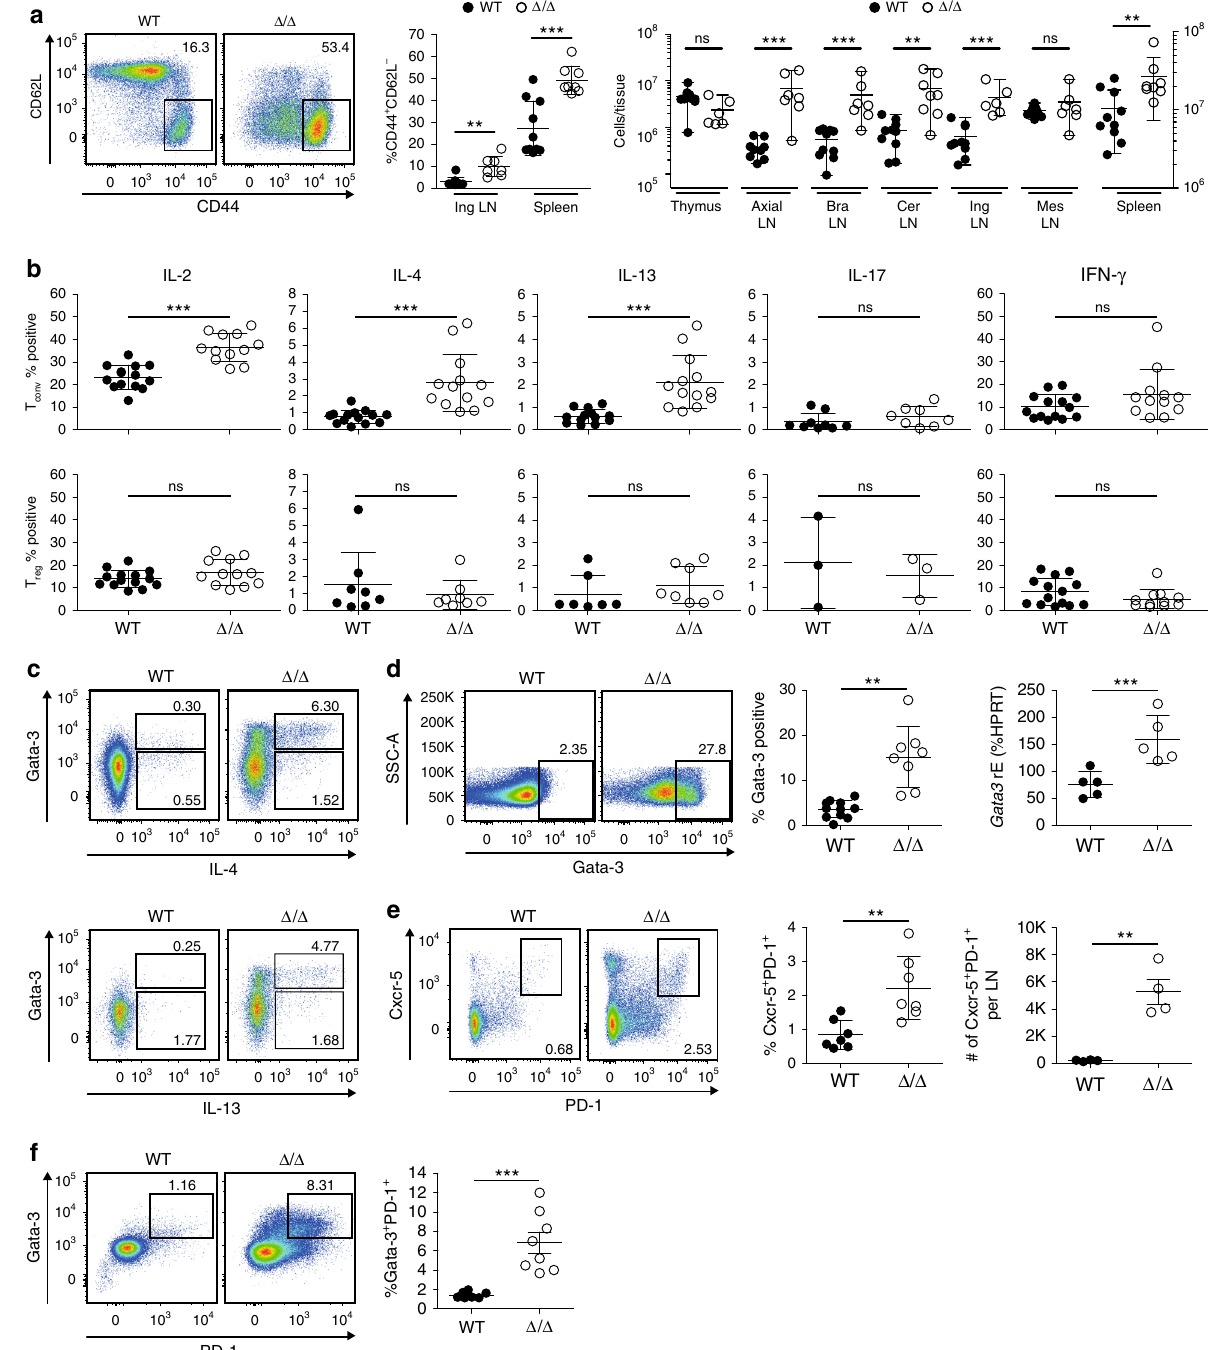
Fig. 3 T conv cells derived from affected Δ / Δ animals are T H 2 polarized. a T conv cells (CD3 + CD4 + CD25 − Foxp3 − ) from spleens of WT and affected Δ / Δ animals stained for CD44 and CD62L expression, quanti fi cation for spleen and LN ( n = 7 – 10, Mann – Whitney test) adjacent to pseudocolor plots. Right panel, T conv cell numbers per tissue ( n = 6 – 10, Mann – Whitney test). Black dots T conv cells in WT animals, open circles Δ / Δ -derived T conv cells, individual mice are shown. b Restimulation of splenic T cells followed by intracellular cytokine staining. Upper panel intracellular cytokines in T conv cells, lower panel in T reg cells (CD3 + CD4 + CD25 + Foxp3 + ). Statistical testing with Mann – Whitney test (IL-2: n = 12 – 14; IL-4: n = 8 – 14; IL-13: n = 7 – 13; IL-17: n = 3 − 9; IFN- γ : n = 12 – 14). c Co-staining of stimulated T conv cells with cytokine and Gata-3 antibody. Upper panel representative dot plots of PMA/Ionomycin-stimulated WT (left) or Δ / Δ (right) T conv cells, with IL-4 staining on X -axis and Gata-3 staining on Y -axis. Lower panel, IL-13 staining. d Left, dot plots of Gata-3 protein staining in spleen-derived T conv cells; middle panel, quanti fi cation of Gata-3-positive cells (% of T conv , n = 8 − 11, unpaired t -test); right panel, Gata3 mRNA in T conv cells (% Hprt , n = 5, unpaired t -test). e Identi fi cation of T follicular helper cells in lymph nodes from WT vs. affected Δ / Δ animals. Tfh cells identi fi ed as CD3 + CD4 + CD8 − CD25 − Foxp3 - Cxcr-5 + PD-1 + T cells and quanti fi ed ( n = 7, unpaired t -test). Total numbers of Tfh cells per LN to the right ( n = 4, unpaired t -test). f CD3 + CD4 + CD8 − CD25 − Foxp3 − T cells in lymph nodes of WT or affected Δ / Δ animals co-stained with PD-1 and Gata-3. Quanti fi cation to the right ( n = 8, unpaired t -test). Data are representative of two or more independent experiments with individual mice ( a , b , d , e , f ) or a single experiment with individual mice ( c ). Source data are provided as a Source Data fi le NATURE COMMUNICATIONS| (2019) 10:1621 |https://doi.org/10.1038/s41467-019-09276-w|www.nature.com/naturecommunications